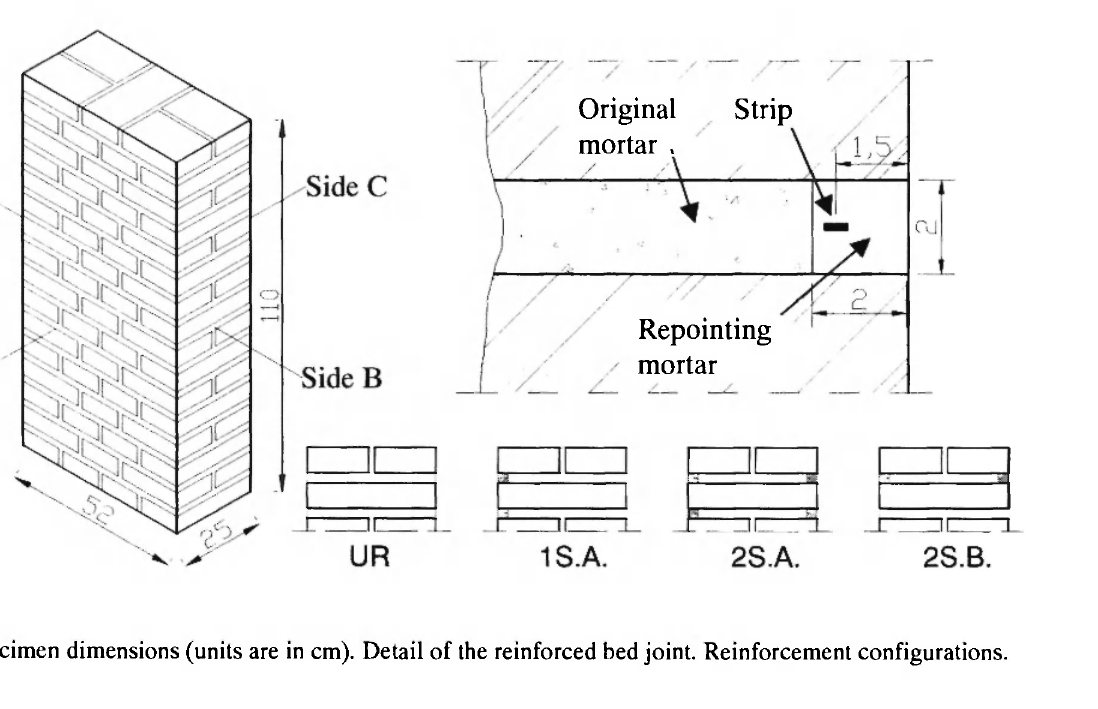
Fig. 8: Specimen dimensions (units are in cm). Detail of the reinforced bed joint. Reinforcement